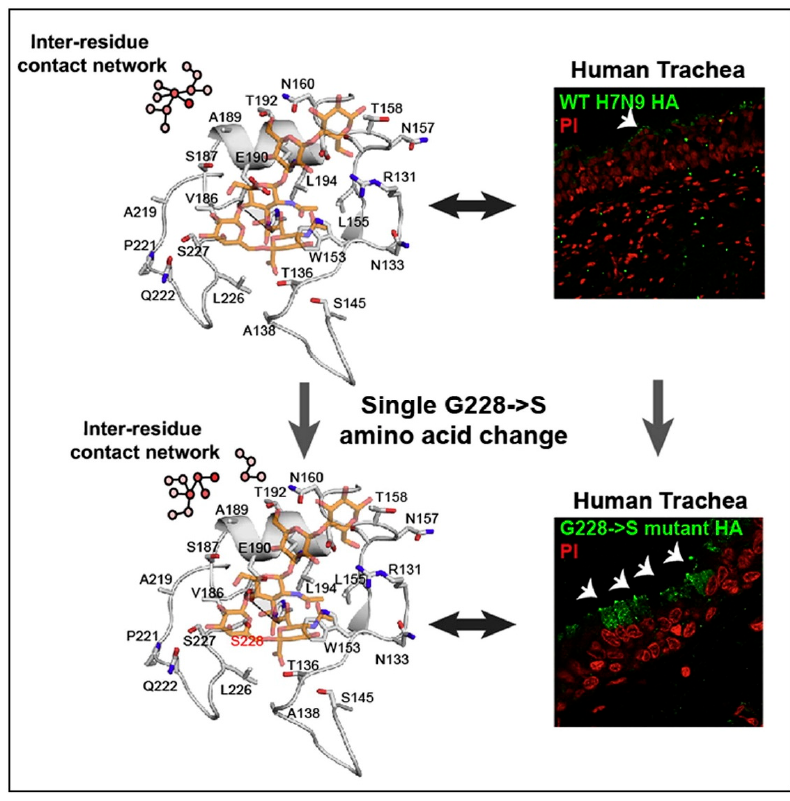
Figure 4. Staining of human trachea cells with G228S hemagglutinin (A/Anhui/1/2013) and a wild type (WT) virus. Tissue sections present recombinant HA stained green, counterstained with propidium iodide in red. The WT virus has not stained cells (top) as intensely as HA-G228S (bottom), demonstrating an increased affinity of the mutated HA for human trachea cells. White arrows indicate specific staining by recombinant HA (in green). Reprinted from [33] , Copyright (2013), with permission from Elsevier.